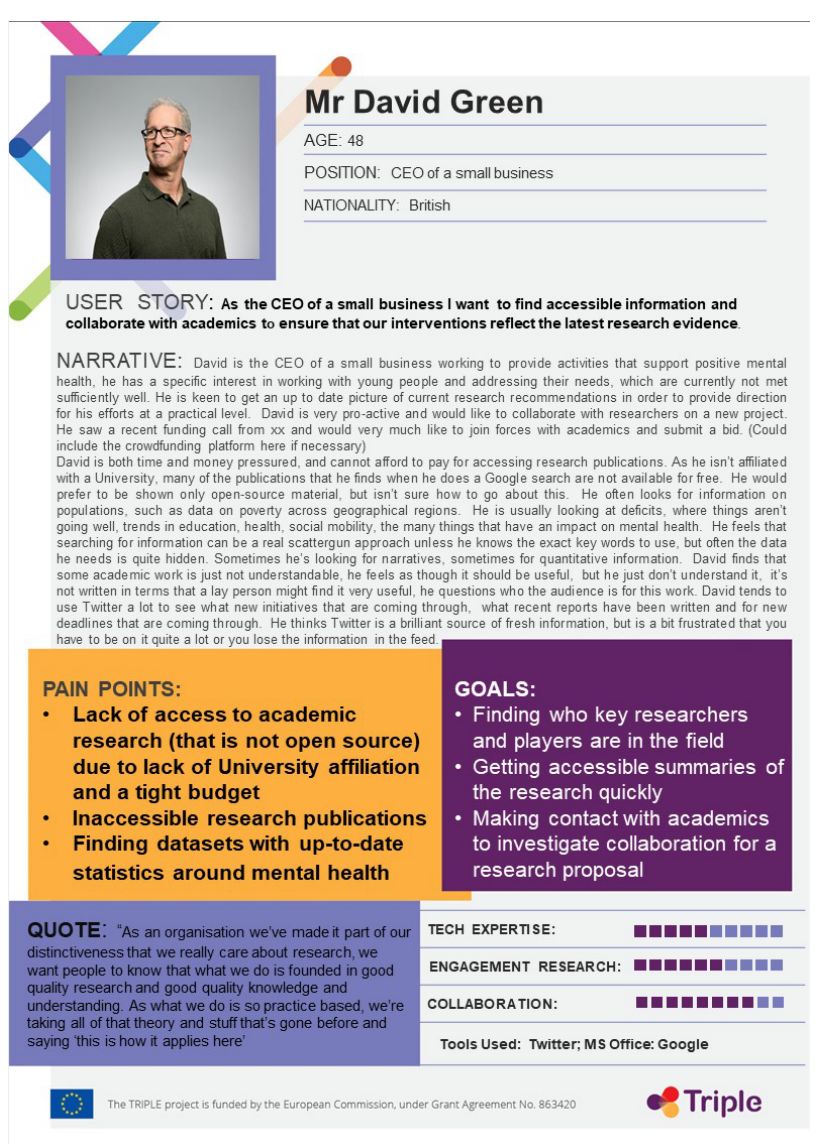
Fig. 1 . Example of a non-academic persona created from the results of the requirement